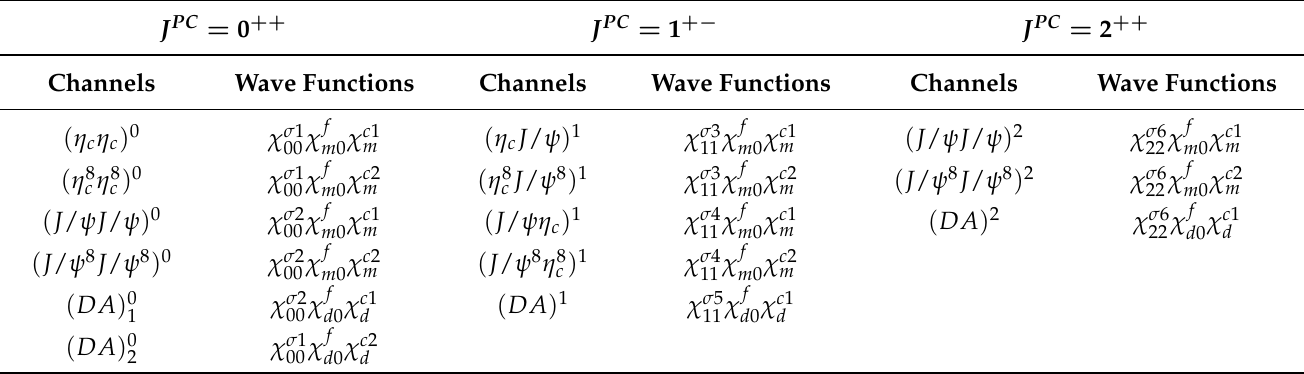
The possible channels and corresponding wave functions for cc ¯ c ¯ c tetraquarks with quantum numbers J PC = 0 ++ ,1 + − ,2 ++ . The channels ( DA ) represent the diquark–antidiquark structures and the superscripts of the channels represent the total angular momentum J